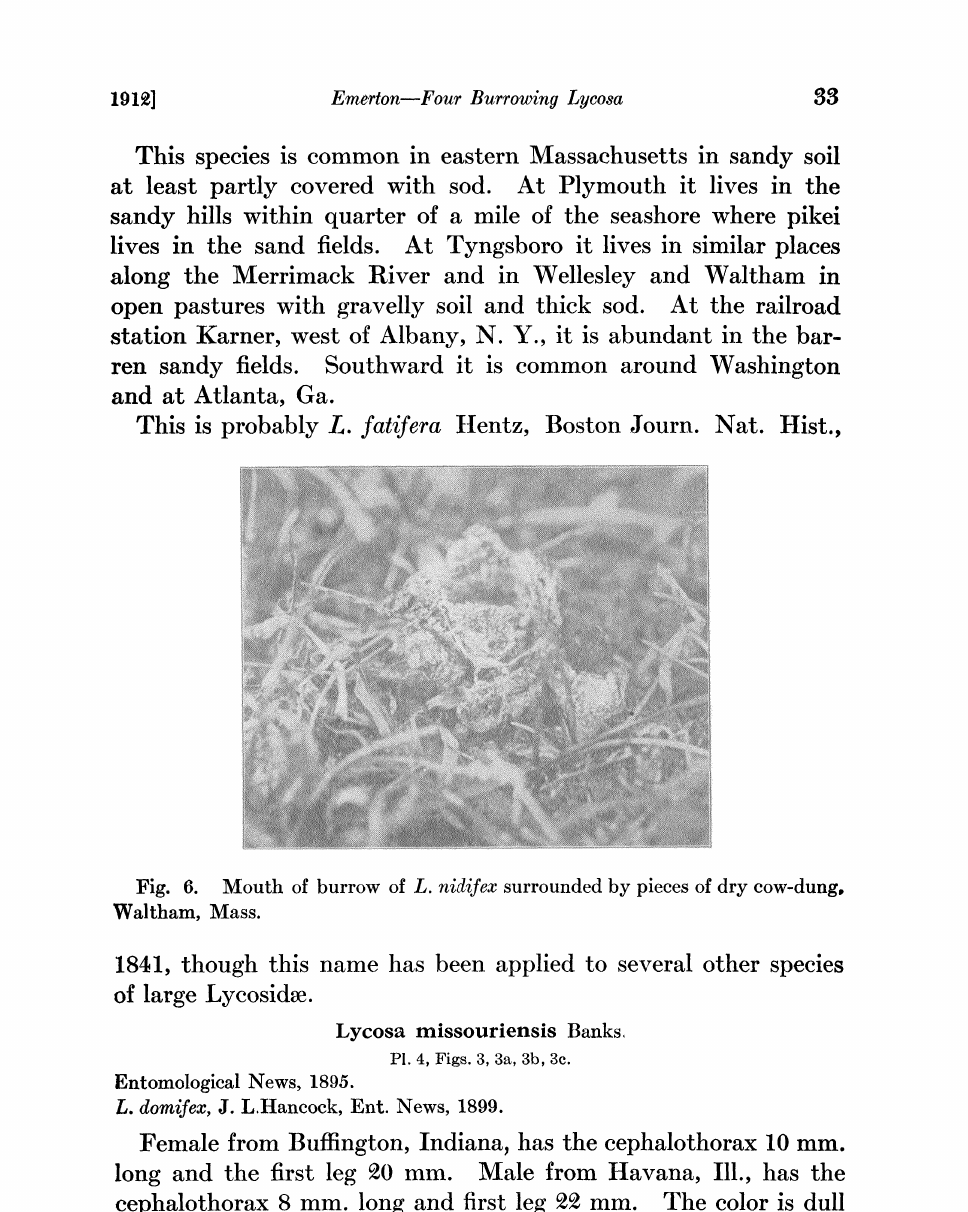
Fig. 6. Mouth of burrow of L. nidifex surrounded by pieces of dry cow-dung, Waltham, Mass. 1841, though this name has been applied to several other species of large